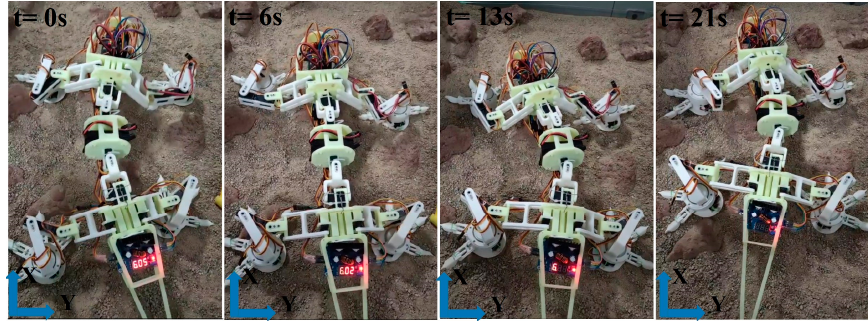
Figure 15. Climbing over a rock on the simulated Mars surface terrains.